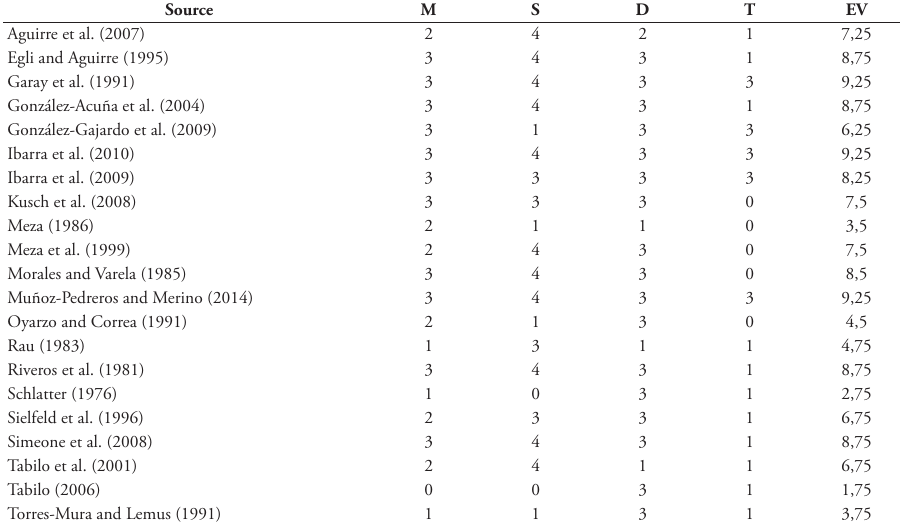
Table 2. Eligibility Value (EV) of the publications analysed. M: census method, S: sampling effort, D: description of the study area and T: type of